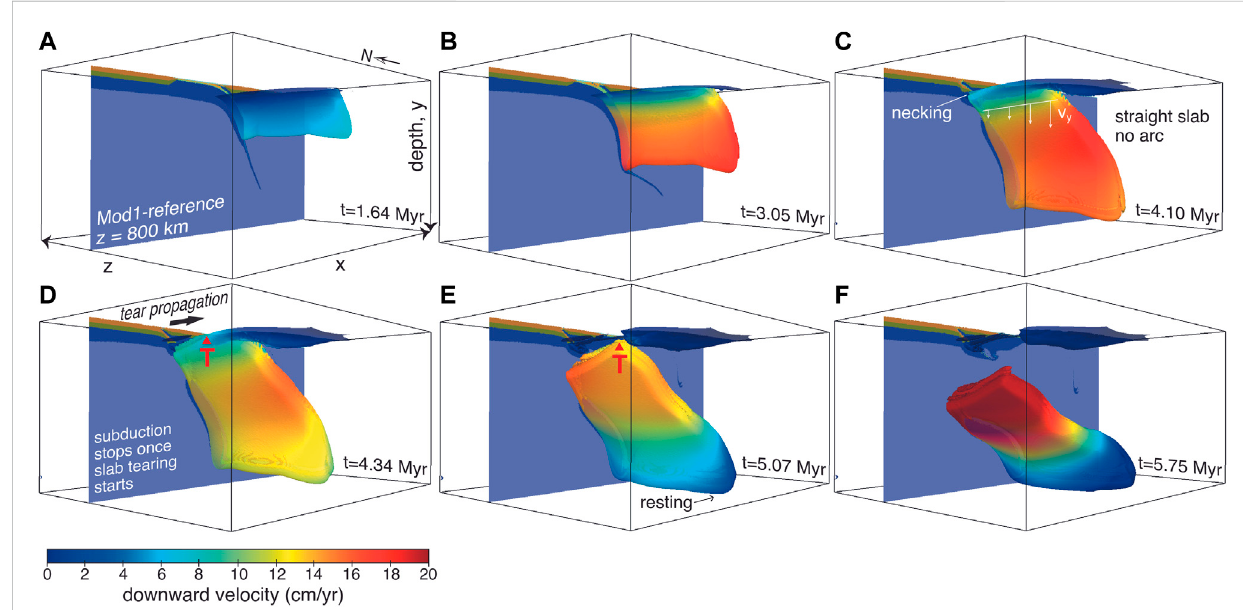
FIGURE 3 The evolution of the slab ’ s downward velocity (Mod1-reference). The slab structure shown here comes from the temperature isosurface, T = 1,300 ° C. The cross-section (z = 800 km) shows the lithology/composition (for rock composition colour legends please refer to Figure 2. The red ‘ T ’ illustrates the position of the slab tear. Prior necking or slab tearing, the slab subducts with little lateral velocity variation across the slab (A, B) . Once the necking and the tearing has started, the higher downward velocity now shifted to side of the slab that is still attached (C – E) . After the slab is completely detached (F) , the slab ’ s downward velocity regained the lateral uniformity of downward